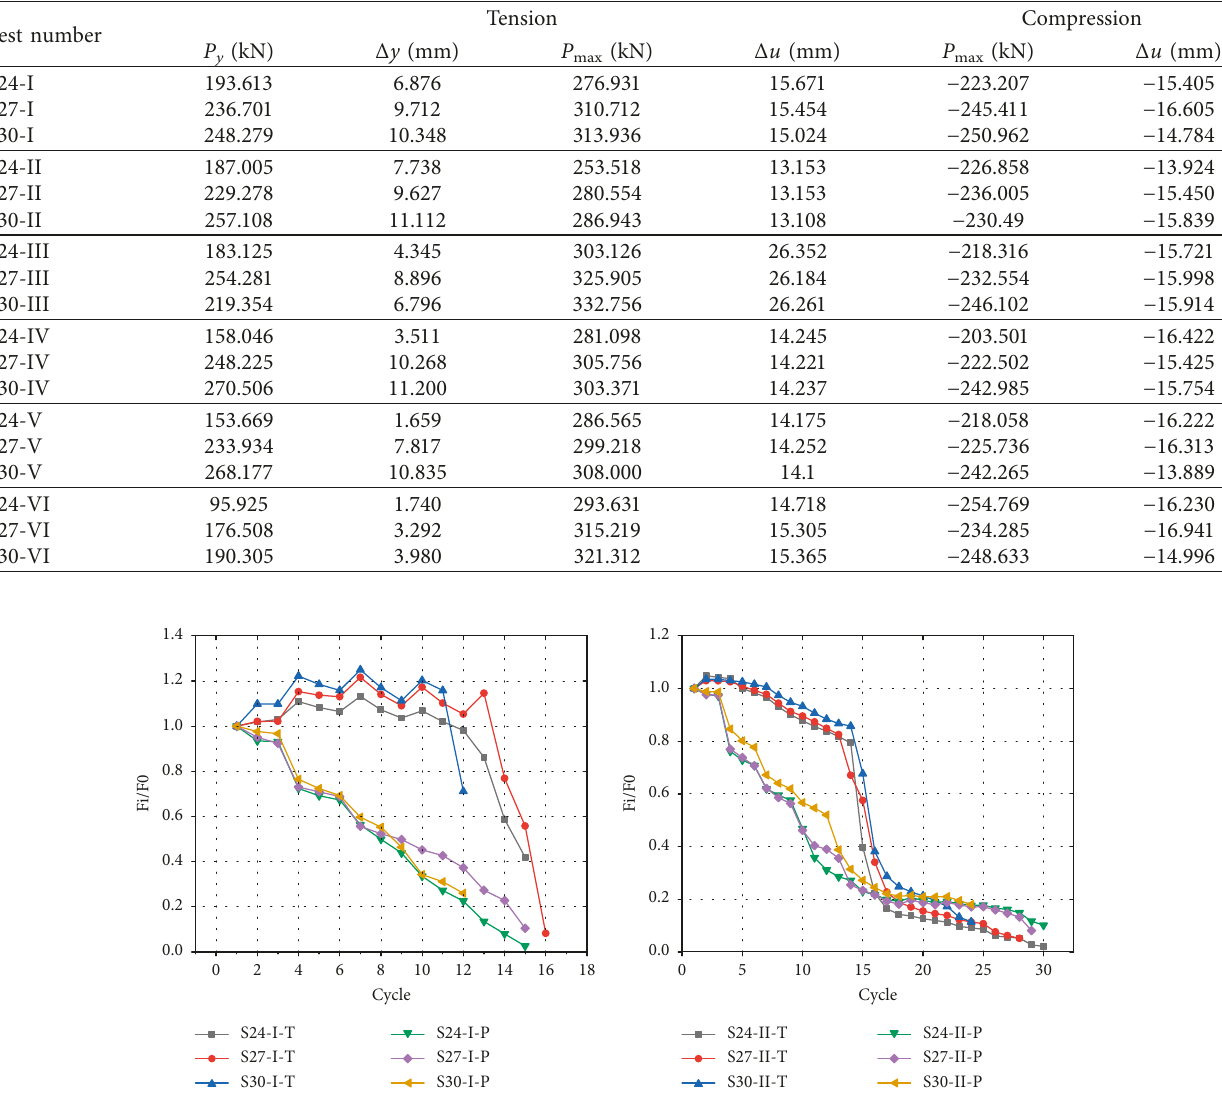
Table 5: Main parameters of skeleton curves of